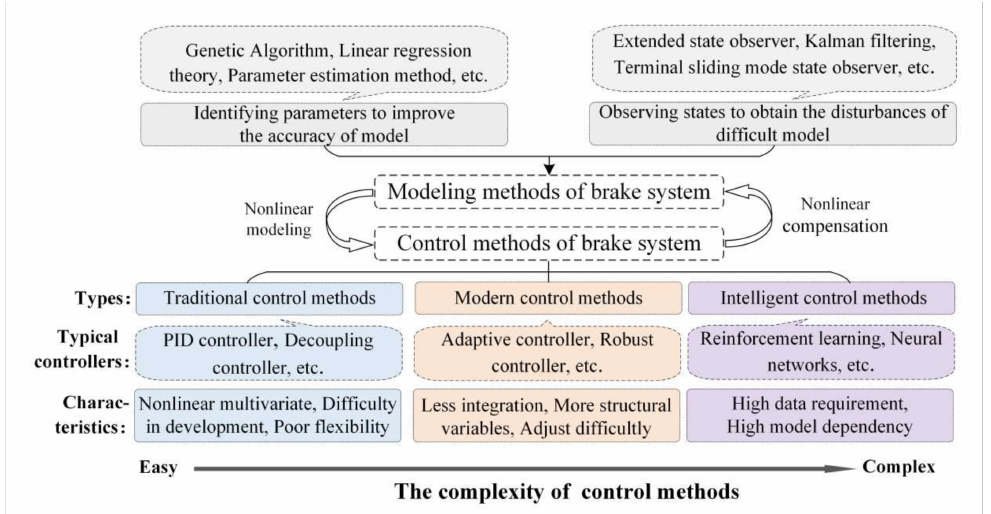
Figure 3. The main methods and characteristics of modeling and control of BBW